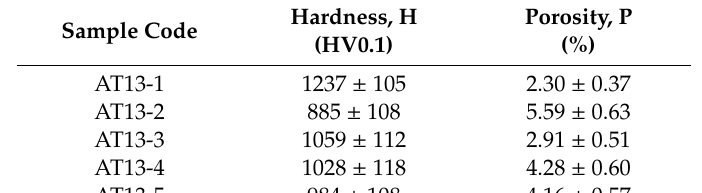
Table 2. Properties of the Al 2 O 3 -13 wt% TiO 2 coatings used in the artificial neural network (ANN) calculations, average ± SD.